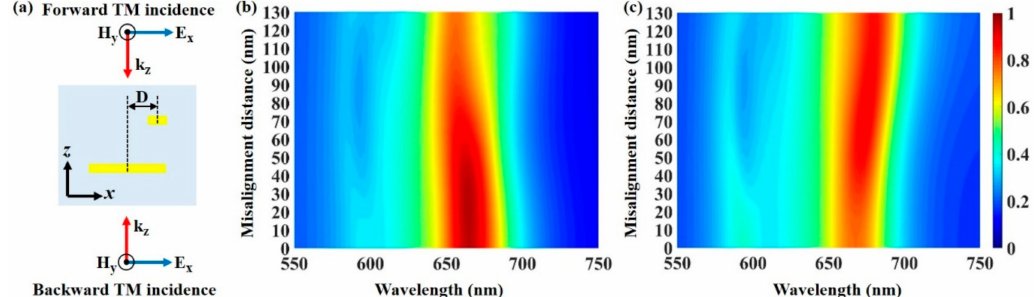
Figure 5. ( a ) Schematic of the center misalignment between the bilayer gratings. D indicates the center misalignment distance in the x -direction. ( b , c ) show the absorption spectra with di ff erent center misalignment distances, D, under forward and backward TM-polarized light incidence,